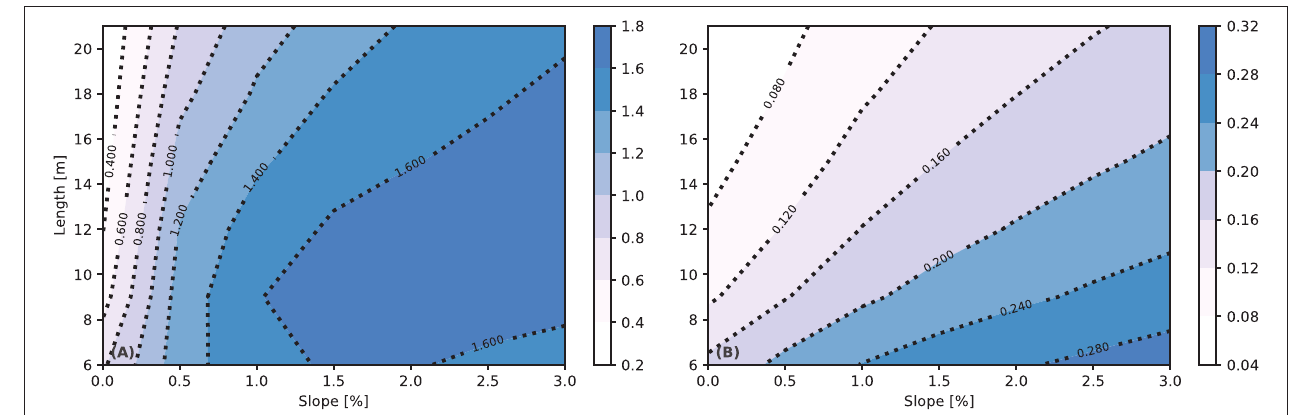
FIGURE 9 | (A) Response surface for the specific peak discharge computed for different combinations of length and slope (mm min − 1 ). (B) Response surface showing computed runoff coefficients ( t = 15 min) as a function of length and slope